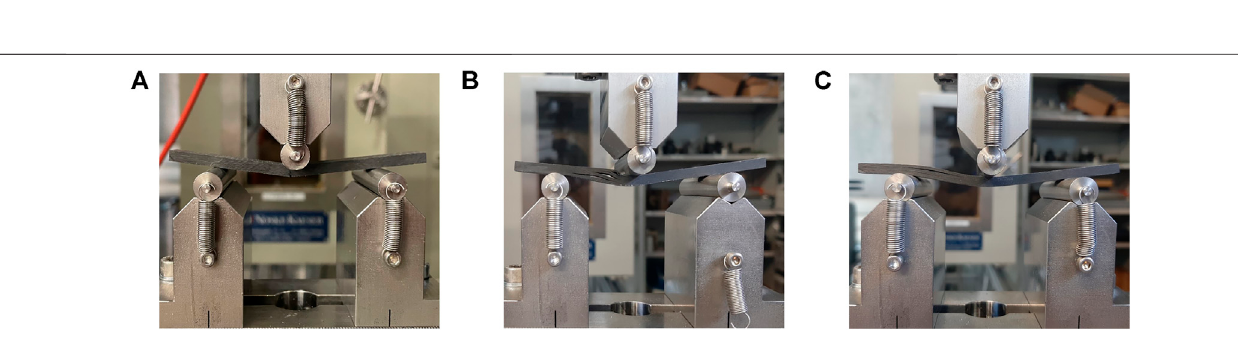
Frontiers in Materials |